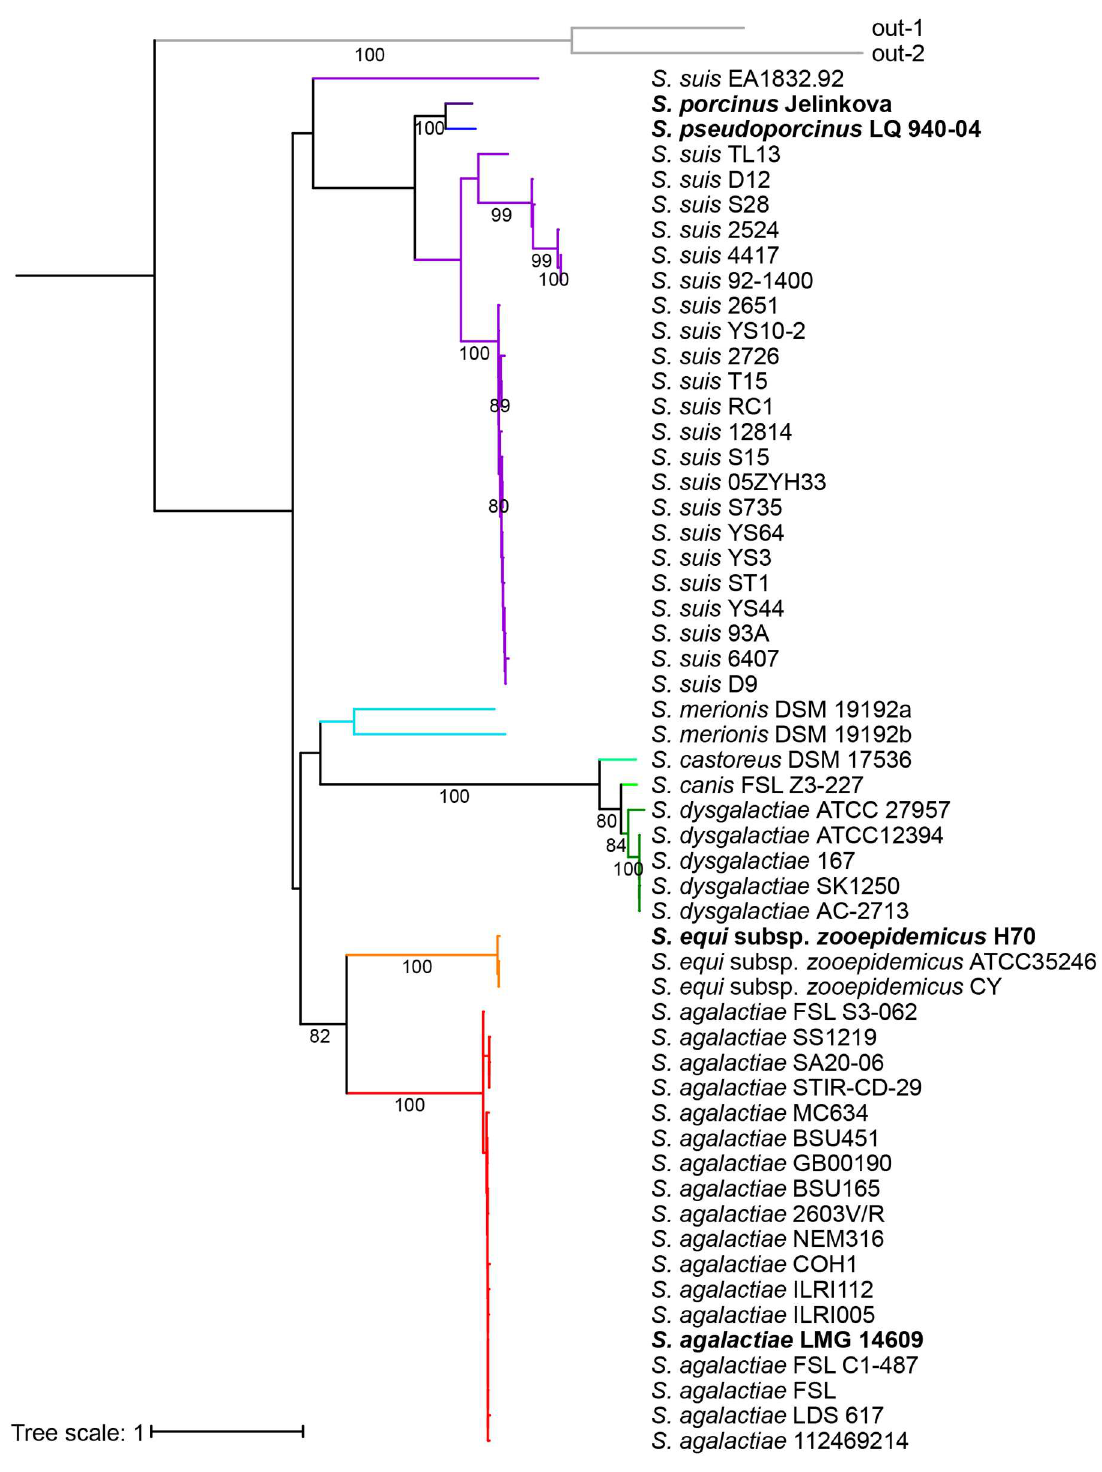
Fig 1. Phylogenetic tree of identified putative IgdE proteases. Phylogenicanalysisof the IgdE_domainof 55 identified putative IgdE proteases. The maximum likelihood(ML) tree was constructed using a Jones-Taylor-Thornton (JTT) model with PhyML. Bootstrap values greater than or equal to 80% are shown. Putative IgdE protease sequencesthat corresponded to the genes cloned for expression of recombinant protein are marked in bold . Tree scale is given as average number of substitutions per